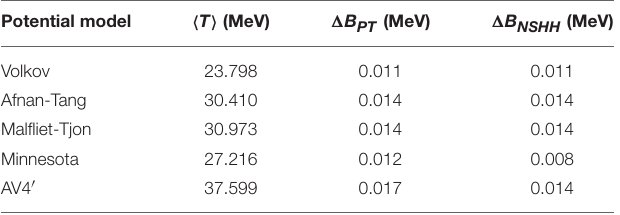
TABLE 9 | Mean value for the kinetic energy operator perturbative theory ( PT ), and 1 B calculated with the NSHH for the different potential models considered in this work.